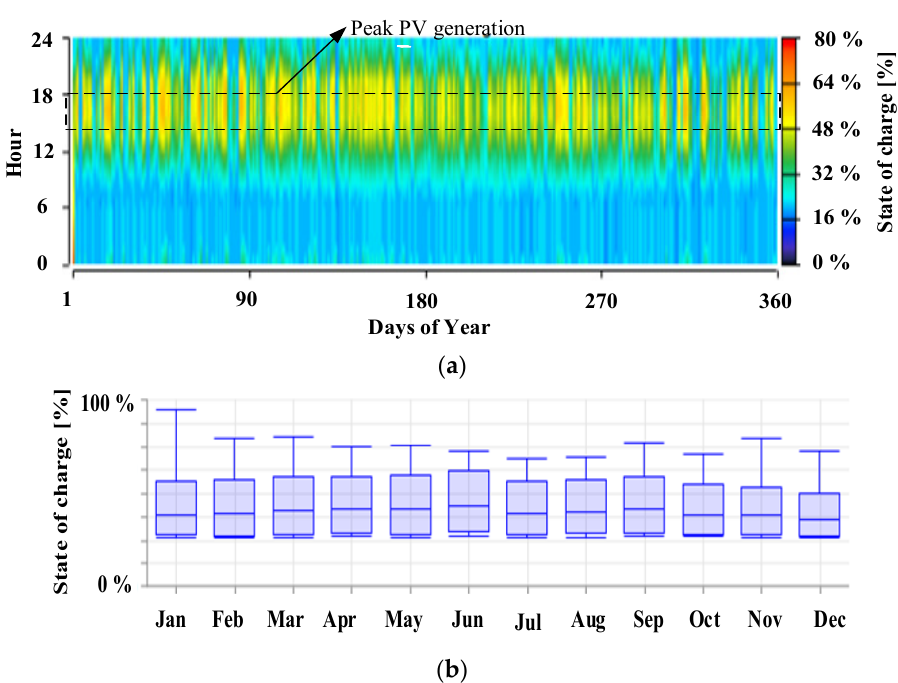
Figure 14. The ESS state of charge: ( a ) in hourly scale; ( b ) in monthly scale.